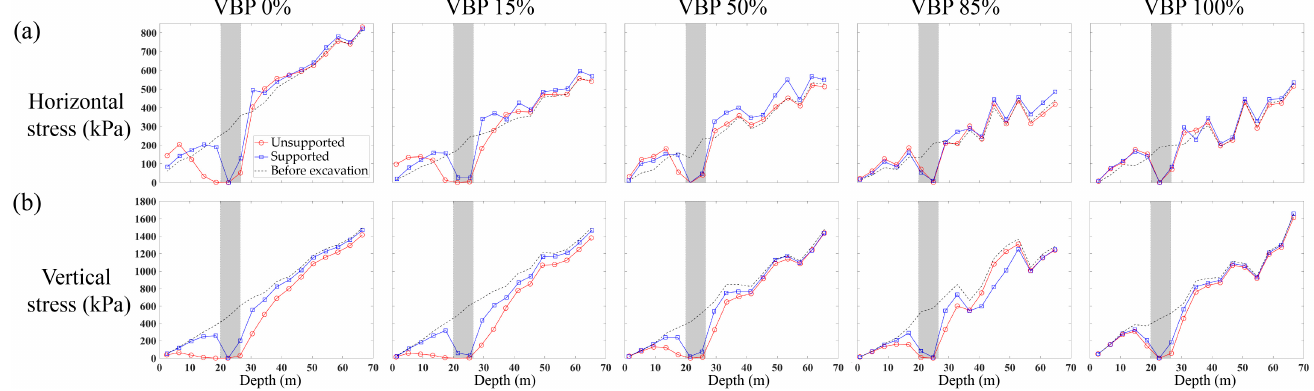
Figure 11. The distribution of ( a ) horizontal and ( b ) vertical stresses along the measuring line. The grey shadow indicates the excavation range.